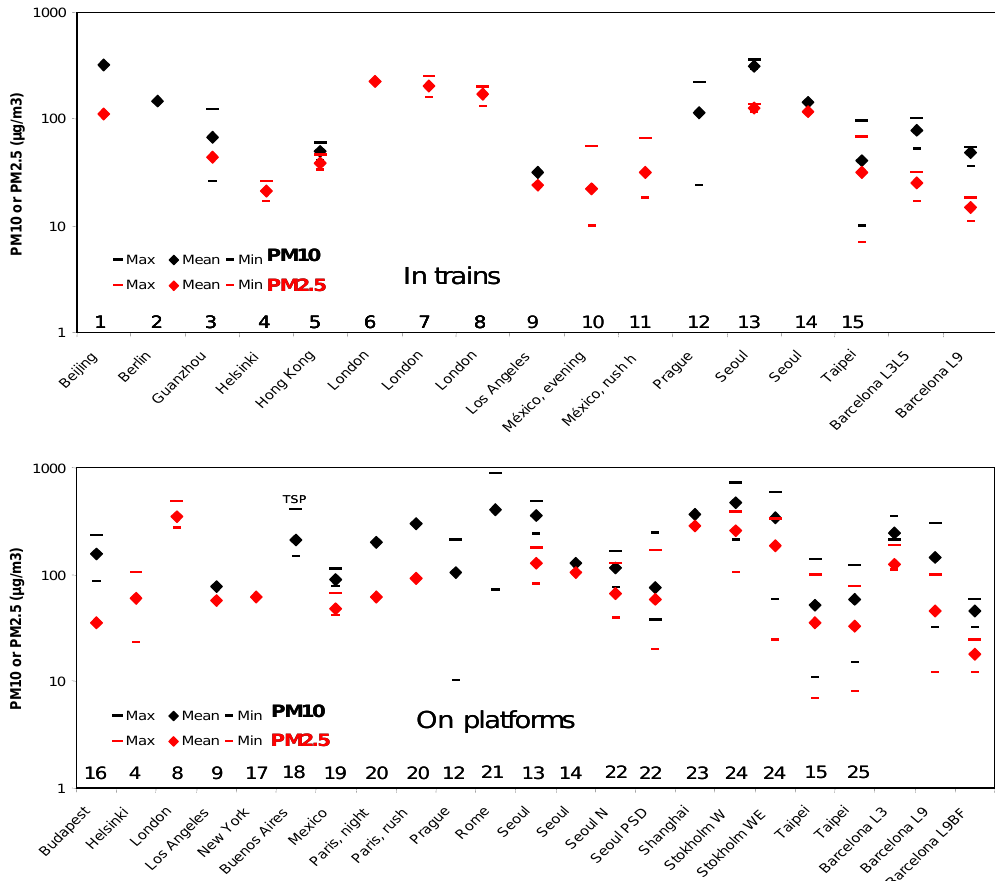
Fig. 6. Comparison of PM 10 and PM 2 . 5 levels measured in trains and on platforms of worldwide metro systems with those obtained in the present study in Barcelona. W, week day, WE, weekend; L3, L5 and L9, metro lines 3, 5 and 9; BF, before the tunnel air uptake ventilation system was fully implemented. 1. Li et al. (2007); 2. Fromme et al. (1998); 3. Chan et al. (2002b); 4. Aarnio et al. (2005); 5. Chan et al. (2002a); 6. Pfeifer et al. (1999); 7. Adams et al. (2001 TS4 ); 8. Seaton et al. (2005); 9. Kam et al. (2011); 10. and 11. G´omez Perales et al. (2007); 12. Braniˇs (2006); 13. Kim et al. (2008); 14. Park and Ha (2008); 15. Cheng et al. (2008); 16. Salma et al. (2007); 17. Chillrud et al. (2004); 18. Murruni et al. (2009), in this case total suspended particles (TSP); 19., M´ugica- ´Alvarez et al. (2012), Raut et al. (2009); 21. Ripanucci et al. (2006); Ho et al. (2012) N and PSD standing for without and with platform screen doors; 23. Ye et al. (2010);